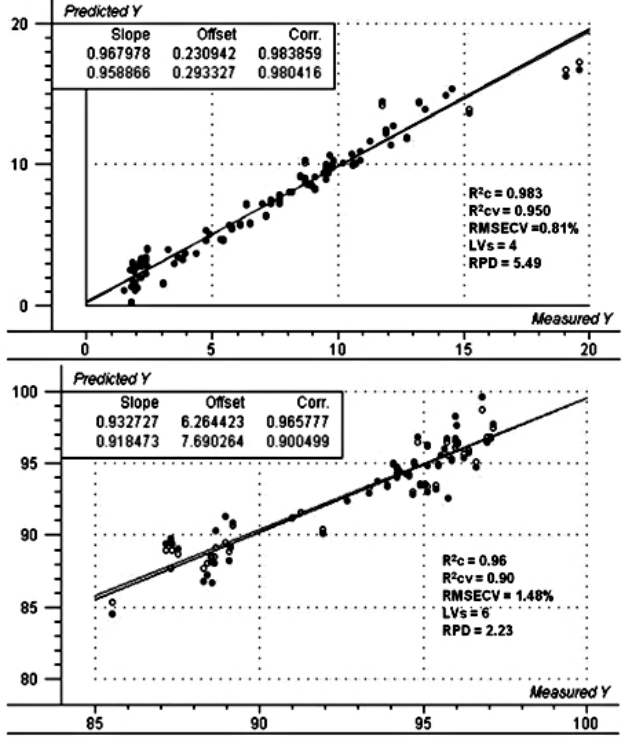
Fig. 1 - Scatter plots relative to the prediction models for the percent- age of weight loss of flowers (top). Scatter plots relative to the prediction models for the percentage of water content of flowers (bottom). Measured values are plotted versus predicted values and significant indexes of calibration and validation are